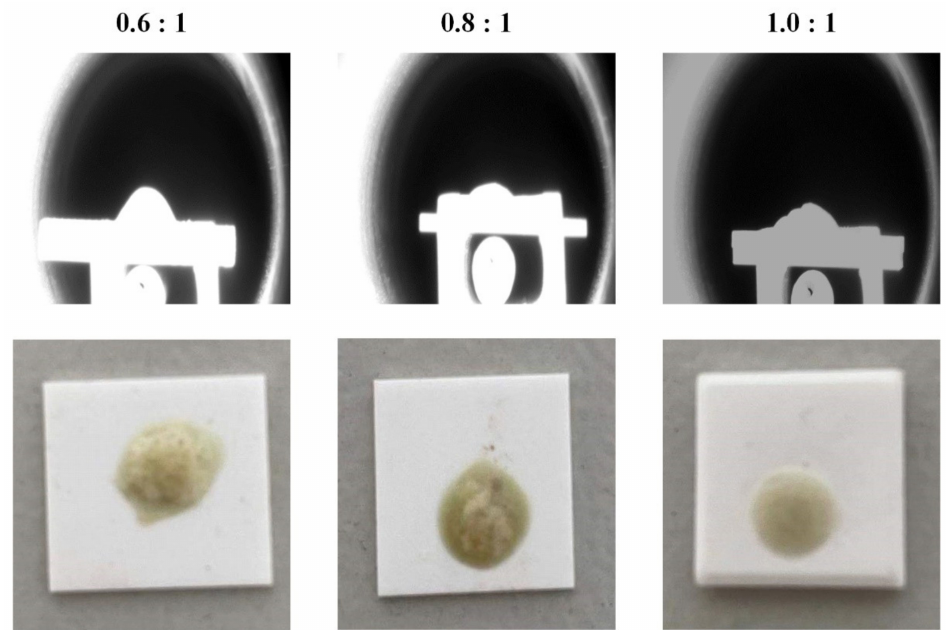
Figure 6. Pictures of the melted samples during melting point